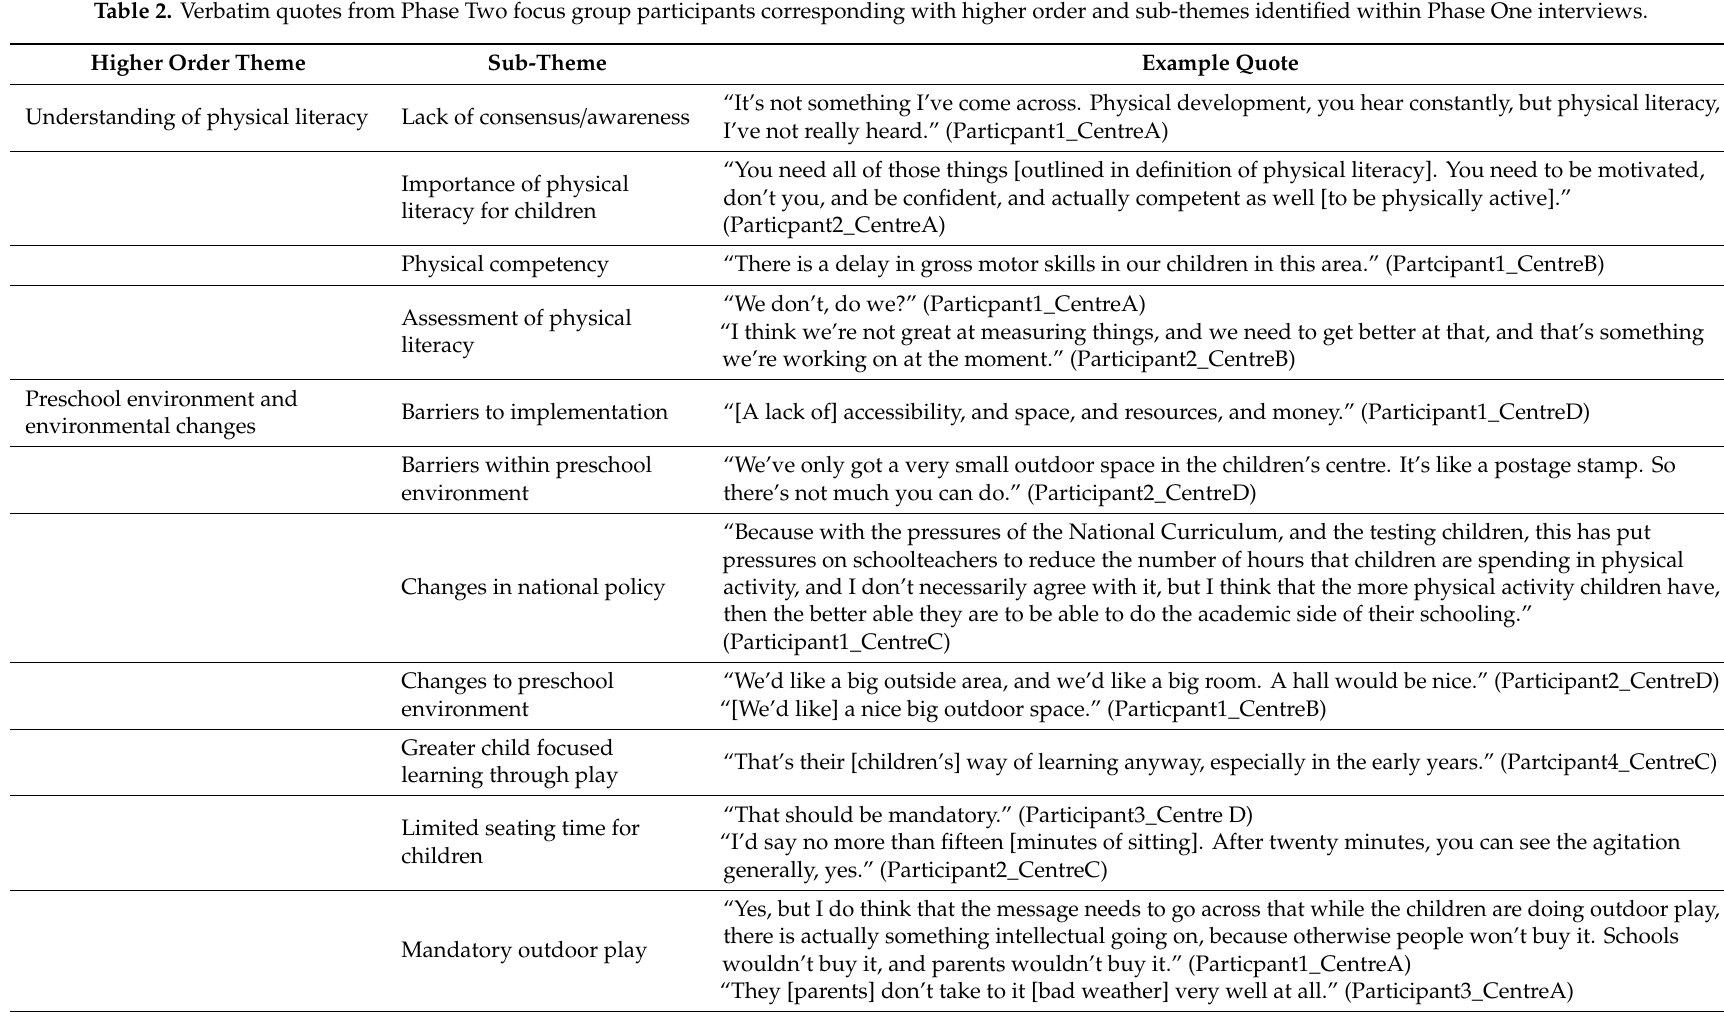
Table 2. Verbatim quotes from Phase Two focus group participants corresponding with higher order and sub-themes identified within Phase One